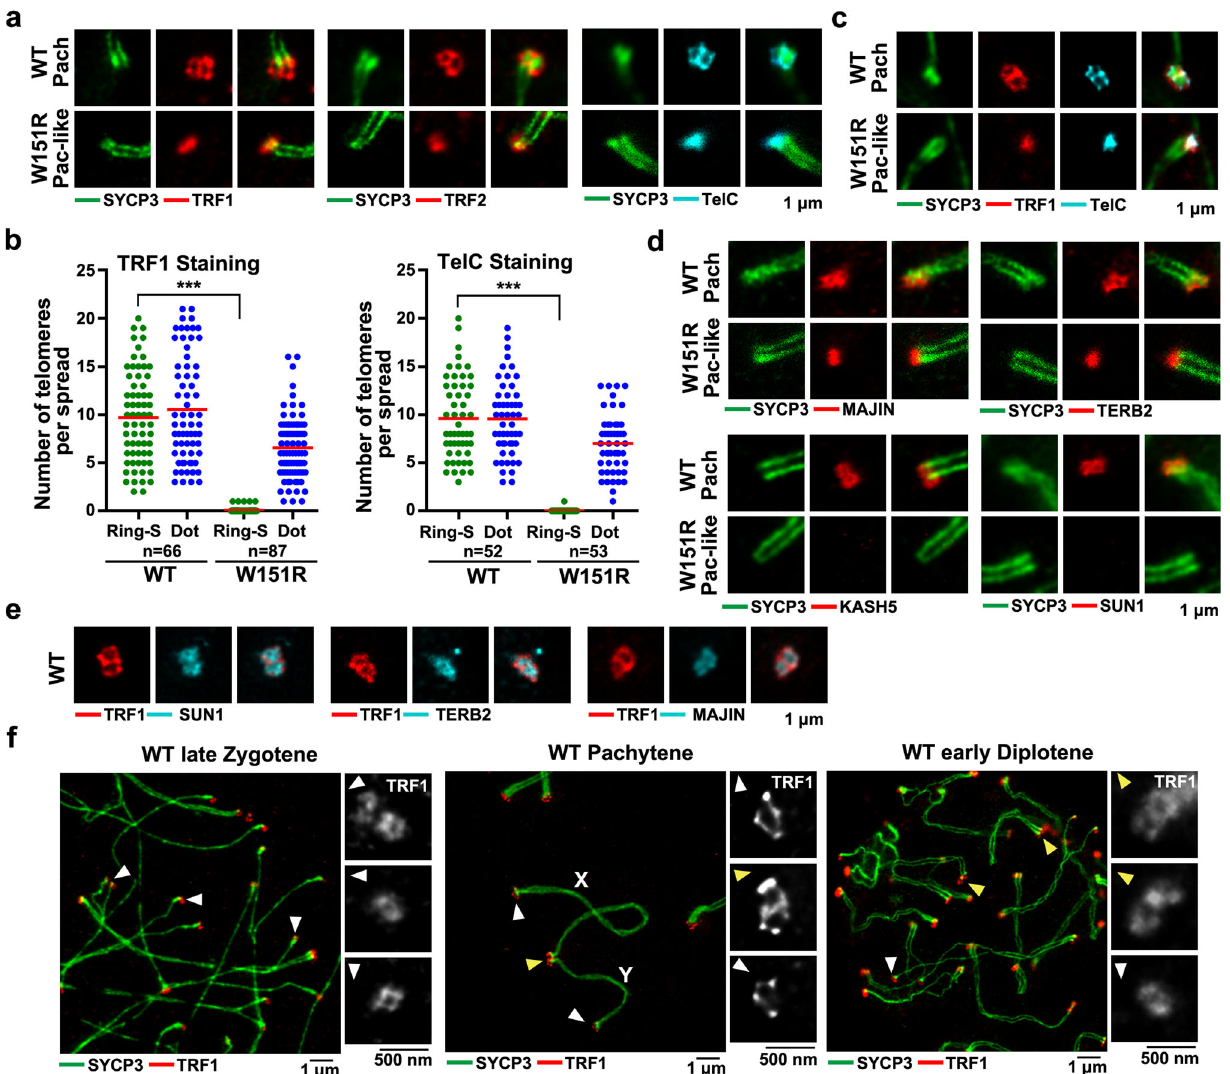
Fig. 6 The SUN1 – SPDYA interaction is required for telomere structures on the NE. a IF analysis by STED of spermatocyte spreads stained for SYCP3 (green) and TRF1 (red), TRF2 (red), or telomeric DNA (telC, cyan). Scale bar, 1 μ m. (Pach pachytene). b Quanti fi cation of the number of ring and fi gure- eight-like TRF1 and TelC structures per spread STED image from panel a . In each spermatocyte spread, only a subset of telomeres can be imaged. Ring-S, ring or fi gure-eight-like structures. Dot, focal structures. A total of n = 66 WT (for TRF1), n = 87 W151R (for TRF1), n = 52 WT (for TelC), and n = 53 W151R (for TelC) spermatocyte spreads were counted. Red lines indicated the mean values. A two-sided Student ’ s t test was performed, *** P = 7.3E-42 (TRF1) and *** P = 8.9E-31 (TelC). c IF-FISH analysis by STED of spermatocyte spreads stained for SYCP3 (green), TRF1 (red), and telomeric DNA (telC, cyan). Scale bar, 1 μ m. d IF analysis by STED of spermatocyte spreads stained for SYCP3 (green) and MAJIN (red), TERB2 (red), KASH5 (red), SUN1 (red). Scale bar, 1 μ m. e IF analysis by STED of spermatocyte spreads stained for TRF1 (red) together with SUN1 (cyan), TERB2 (cyan) or MAJIN (cyan). Scale bar, 1 μ m. f IF analysis by STED of WT chromosome spreads stained for SYCP3 (green) and TRF1 (red). Insets show TRF1 ring structures at asynapsed telomeres (white arrowheads) and fi gure-eight-like structures at synapsed telomeres (yellow arrowheads), respectively. X and Y indicate chromosomes X and Y, respectively. Scale bars, 1 μ m; 500 nm (insets). Source data are provided as a Source Data fi